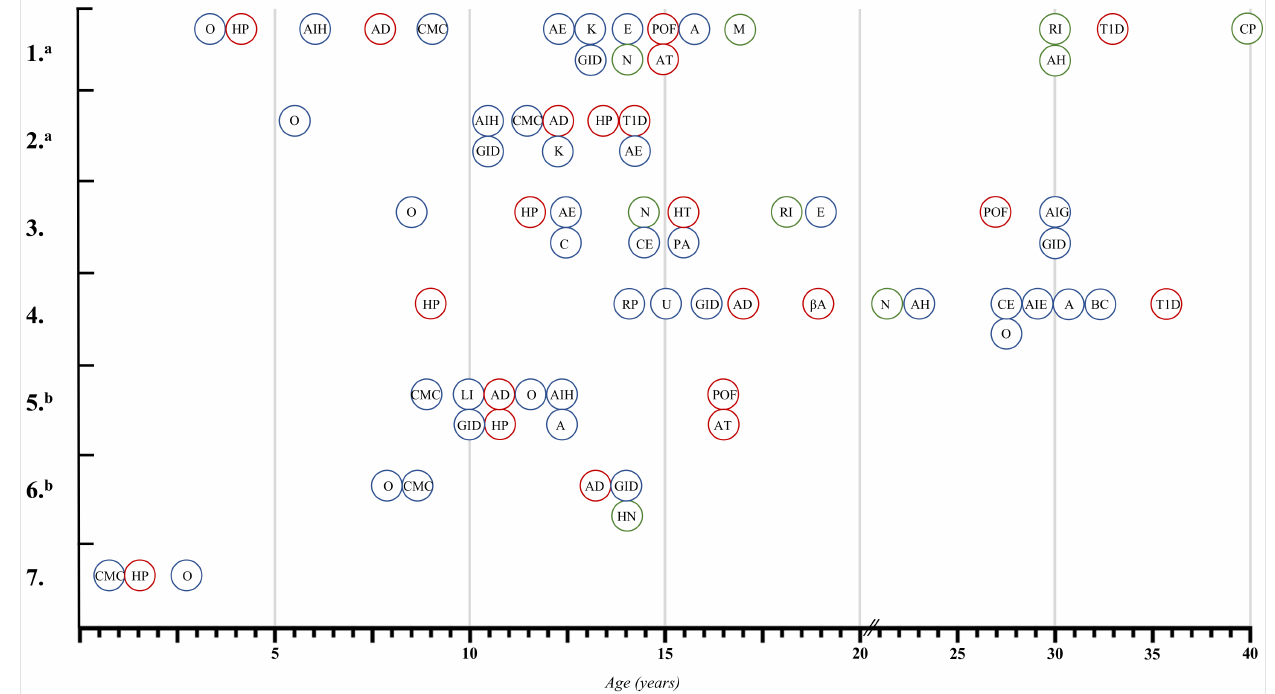
Figure 2. Chronological presentation of diseases in all of patients with APECED syndrome enrolled in the study. O, onychodystrophy; HP, hypoparathyroidism; AIH, autoimmune hepatitis; AD, Addison’s disease; CMC, Chronic mucocutaneous candidiasis; AE, albinism of eyelashes; K, keratitis; GID, gastrointestinal dysfunction; E, enamel dysplasia; N, nephrocalcinosis; POF, premature ovarian failure, AT, autoimmune thyroiditis; A, alopecia; M, megacolon; RI, renal insufficiency; AH, albinism of hair; T1D, type 1 diabetes; CP, colon perforation; C, cheilosis; CE, candidiasis of esophagus; HT, hyperthyroidism; PA, pernicious anemia; AIG, autoimmune gastritis; RP, retinitis pigmentosa; U, prolonged urticaria and angioedema; β A, positive GADA- 65 and ICA β cell antibodies; AH, arterial hypertension; AIE, autoimmune encephalitis; BC, bilateral cataract; LI, liver insufficiency; HN, hydronephrosis; a siblings; b siblings. Endocrinopathies are marked with red circle, while non-endocrinopathies are marked with a blue circle, and non-autoimmune other manifestations are marked with a green